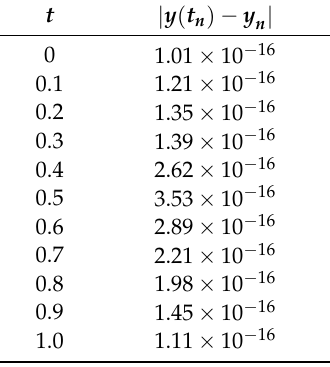
Table 2. The errors for Example 2.